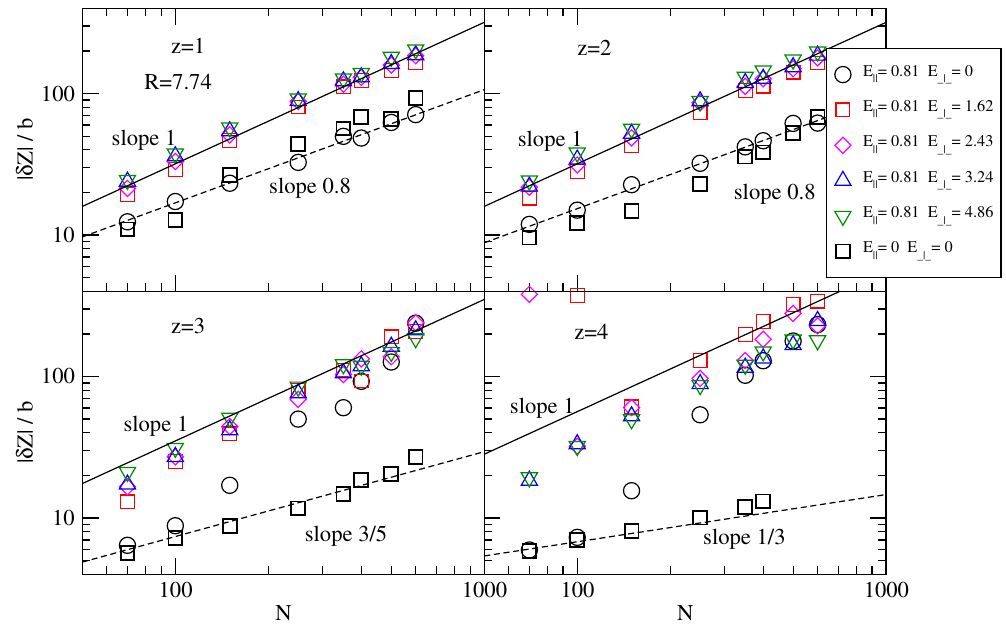
Figure 6. Axial extension | δZ | = | min ( z ) − max ( z ) | ( i = 1 , N ) along the cylinder axis i i normalized by average bond length b as a function of chain length N , in a cylinder of radius R = 7 . 74 , for multivalent counterions of valency z = 1 , 2 , 3 , 4 , transversal field values E = 0 , 1.62, 2.43, 3.24, 4.86 and longitudinal field E = 0 . 81 . The static case of zero ⊥ k applied field, E = 0 and E = 0 , is also ⊥ k